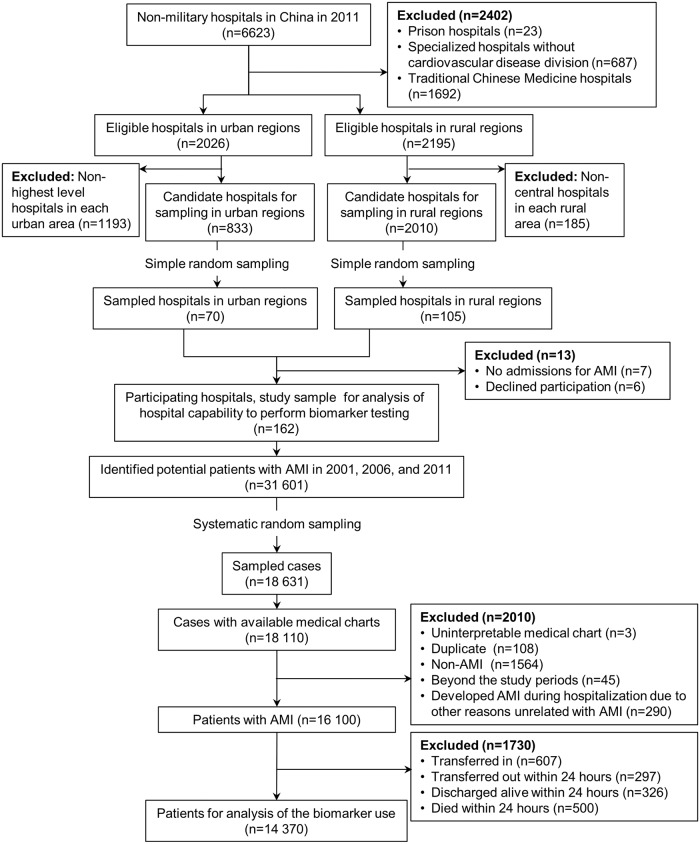
Hospital and patient sample.AMI = acute myocardial infarction.